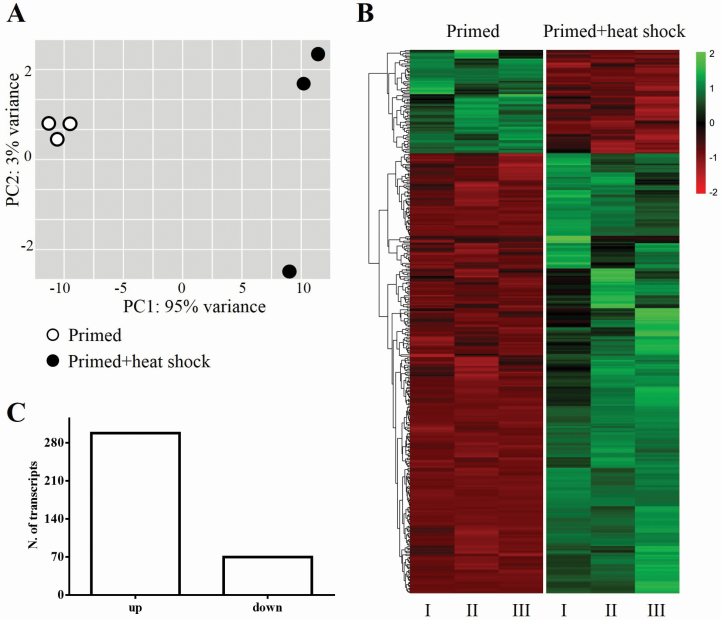
Seed expression profile of S. lycopersicum primed and primed+heat shock treatment (38 °C/32 % RH). (A) Principal component analysis of expressed genes. (B) Heatmap of differentially expressed genes. (C) Number of up- and down-regulated transcripts of differentially expressed genes.